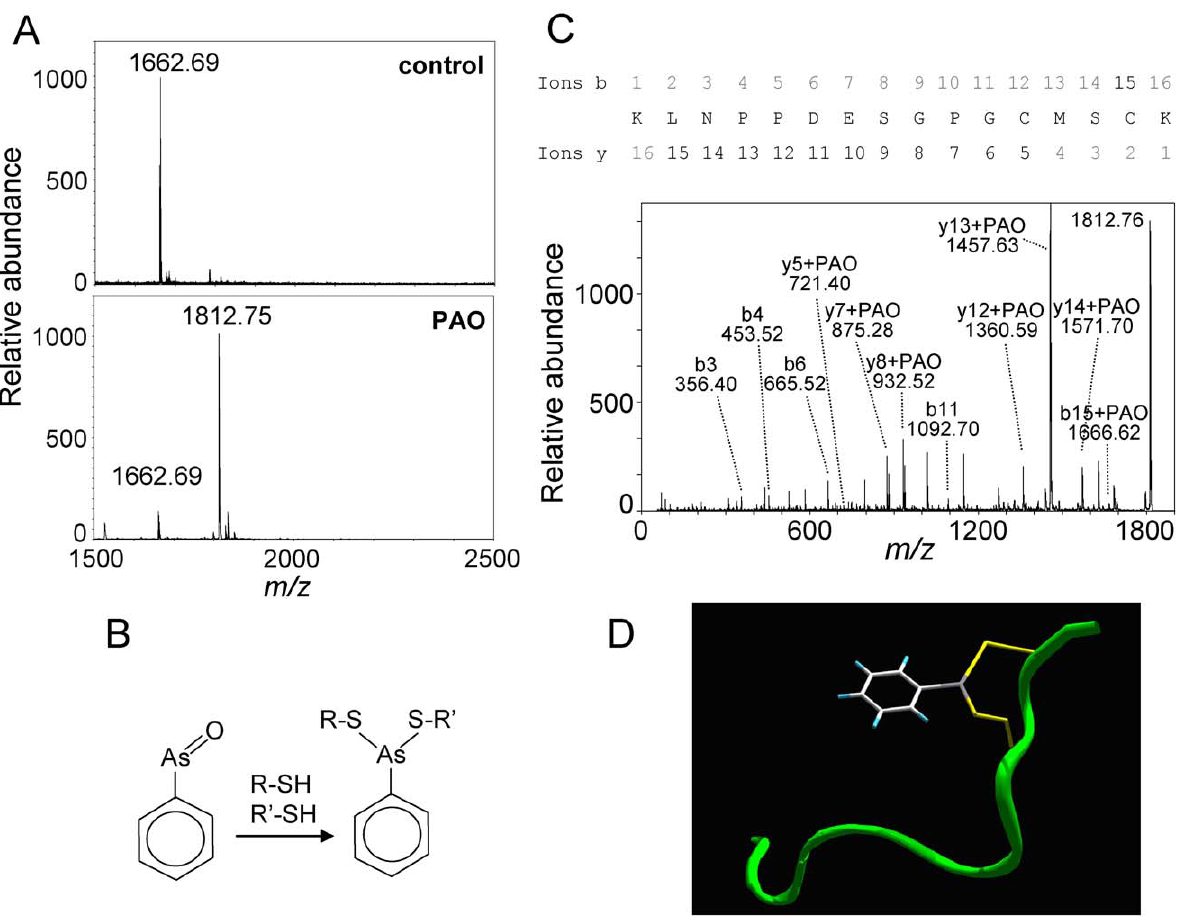
Figure 2. Modification of the K170-K185 peptide by PAO. (A) The K170-K185 peptide was incubated with PAO and analyzed by MALDI-TOF MS. Results are representative from at least four assays. (B) Scheme of the formation of a PAO adduct with two thiol groups. (C) Analysis of the PAO- peptide adduct by MALDI-TOF-TOF MS/MS analysis. The sequence of the peptide with the fragments generated is shown for reference. (D) Ribbon diagram for the theoretical backbone structure of H-Ras K170-K185 peptide model (in green) modified by PAO addition. The side-chains of the cysteine residues and PAO are displayed in yellow and a default atom-type color scheme, respectively.